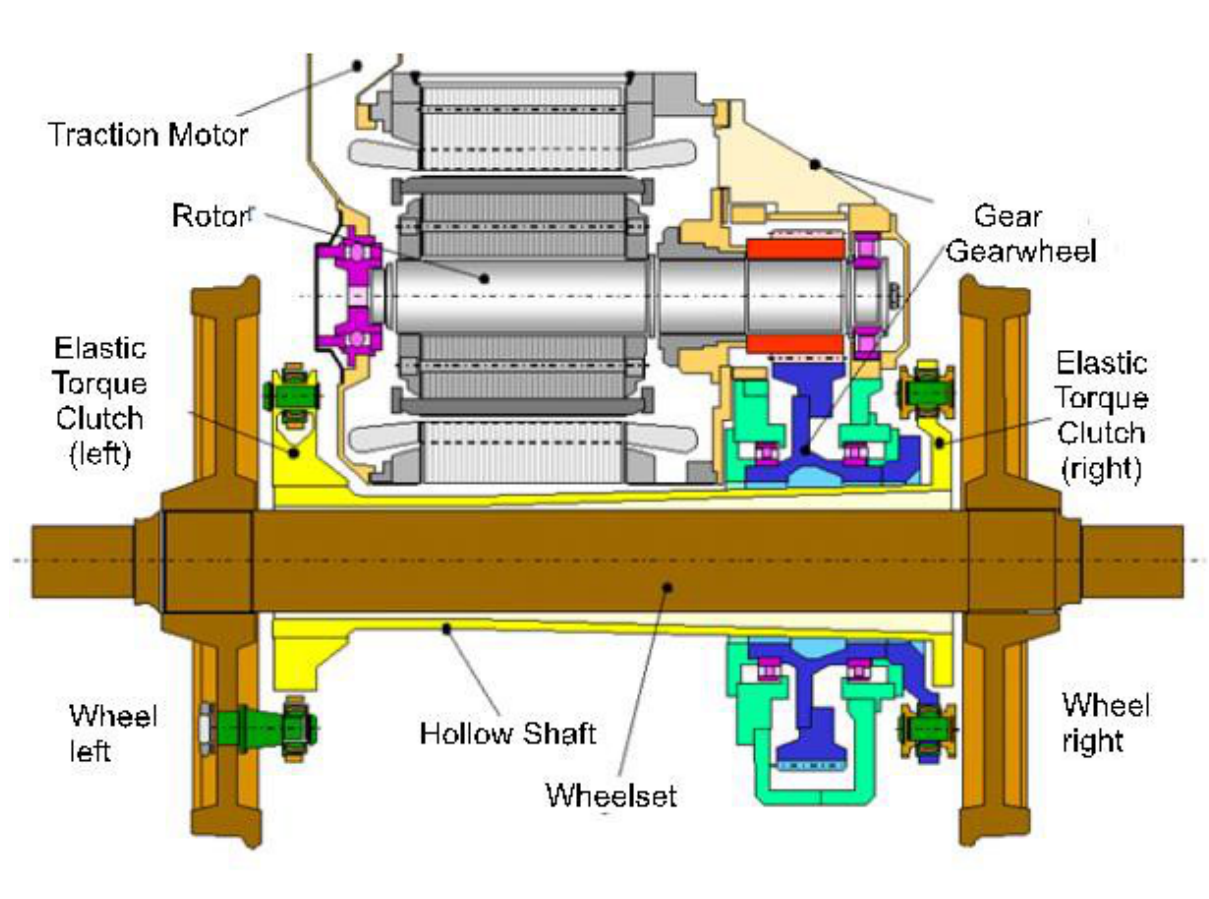
Figure 10. Locomotive fully-sprung drive – cross section [7].